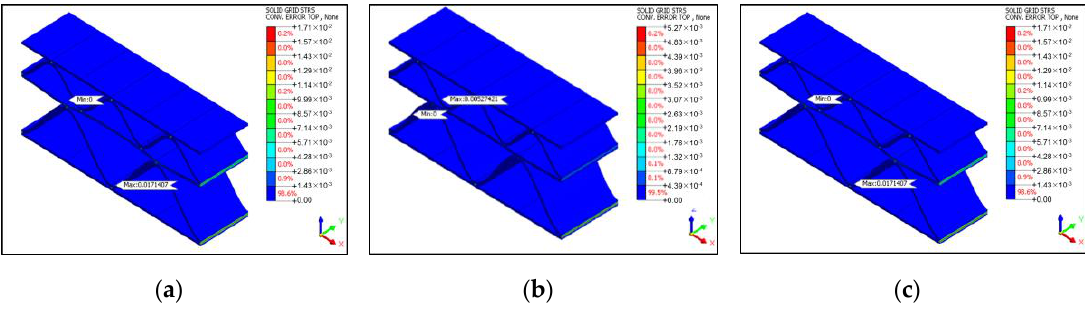
Figure 8. Mesh convergence error for vertical displacement analysis (example: AB/F-DW), they should be list as: ( a ) X-direction (1.71%); ( b ) Y-direction (0.53%); ( c ) Z-direction (3.05%).